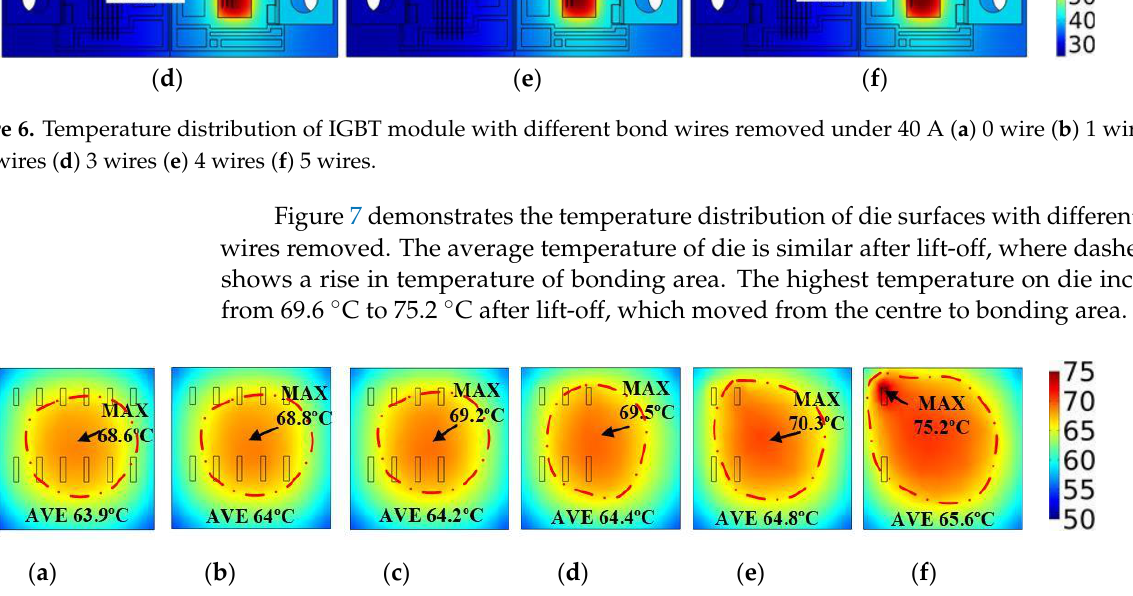
Figure 7. Junction temperature distribution of IGBT die with different wires removed under 40 A ( a ) 0 wire ( b ) 1 wire ( c ) 2 wires ( d ) 3 wires ( e ) 4 wires ( f ) 5 wires.